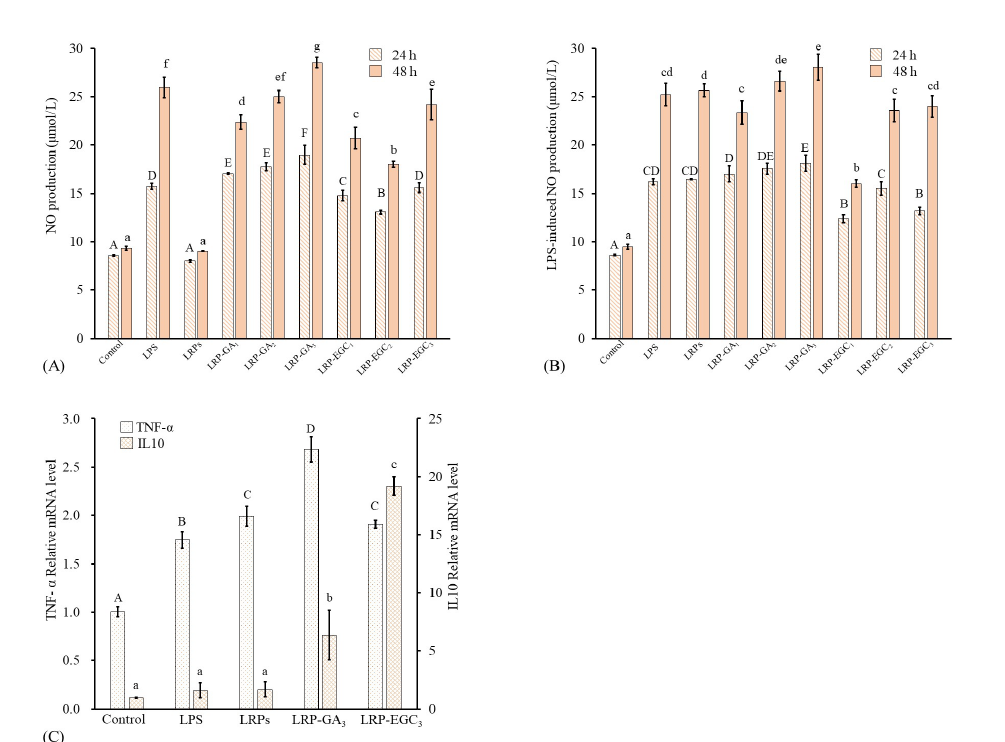
Figure 8. Macrophage-stimulating activities of LRPs and LRP-phenol complexes. ( A ) NO production of RAW264.7 cells stimulated by LRPs and LRP-phenol complexes; ( B ) NO production of LPS-induced RAW264.7 cells suppressed by LRPs and LRP-phenol complexes; ( C ) mRNA expression of cytokines (TNF- α , IL10) in RAW264.7 cells stimulated by LRPs, LRP-GA 3 , and LRP-EGC 3 . Means of the samples with different letters (A–F, a–g) differ significantly ( p <